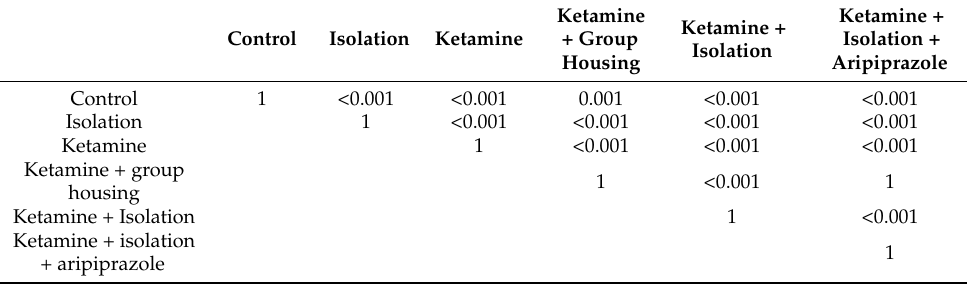
Table 10. All p -values following the post hoc comparison for the level of SOD in the hippocampus.